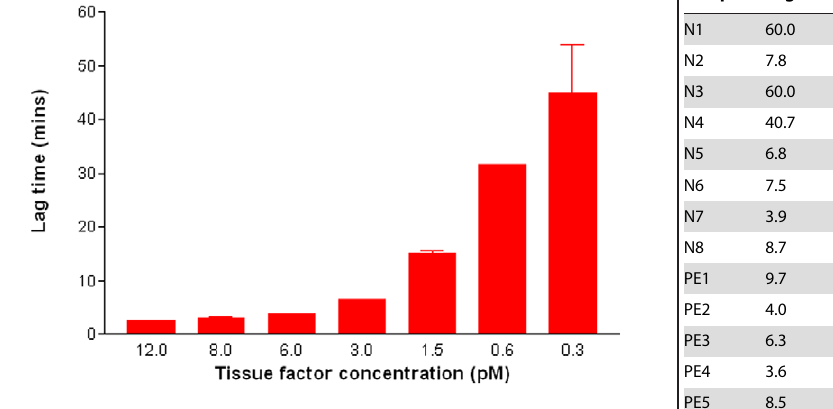
Figure 2. The effect of recombinant tissue factor on thrombin generation lag-time. Recombinant tissue factor was added to platelet poor plasma (final concentration 0.3–12pM). Following the addition of 4 m M phospholipid and 16 nM CaCl 2 , the mean lag time to start of thrombin generation was recorded. Error bars represent the standard deviation.